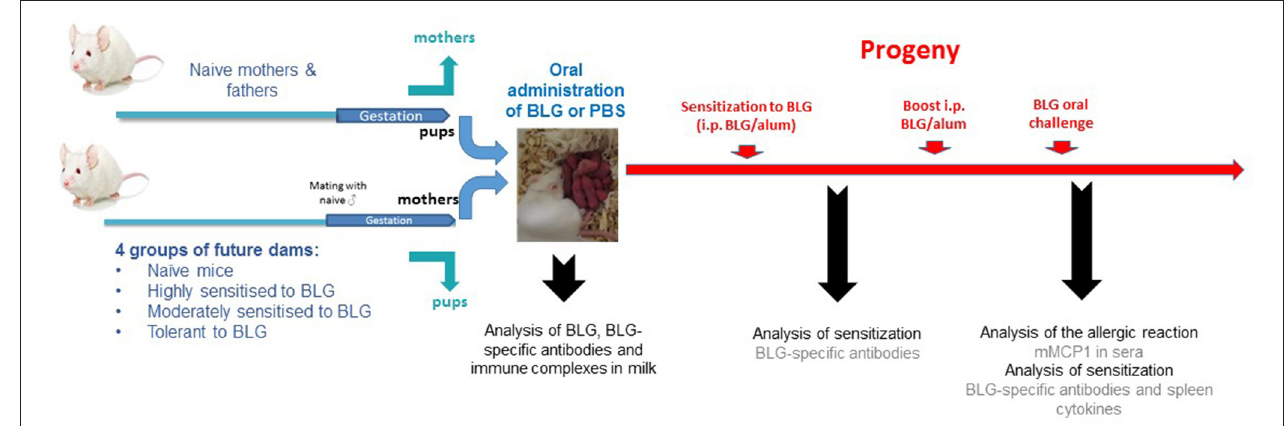
FIGURE 1 | Experimental protocol: BALB/cJ future dams were either kept naïve, moderately (intra-gastric gavage with BLG, and Cholera toxin ) or highly (intra-peritoneal administration of BLG/alum) sensitized to BLG, or rendered tolerant to BLG (intra-gastric gavage with BLG alone) before mating with naïve males. At delivery, pups of treated mothers were replaced by pups from naïve-synchronized mothers in order to prevent interferences from in utero effects. Lactating mothers from each group then received BLG or PBS by i.g. gavage every other day, during the whole period of lactation. Breastmilk was collected 10 days post-partum by pooling stomach contents from 6 to 10 male pups per mother group to assess BLG, BLG specific antibodies, and BLG-immune complexes. The female progeny was then experimentally sensitized by i.p. injection of BLG and Alum when 5 weeks-old and BLG-specific IgE, IgG1, and IgG2a were measured 3 weeks later. A boost injection was performed 21 days after the first i.p. sensitization, and 2 weeks later, all mice were orally challenged with 15mg of purified BLG. Plasma was collected 60min later, both to assess allergic sensitization and elicitation of the allergic reaction. Mice were then sacrificed and spleens were pooled to assess ex vivo BLG-specific cytokine secretion.